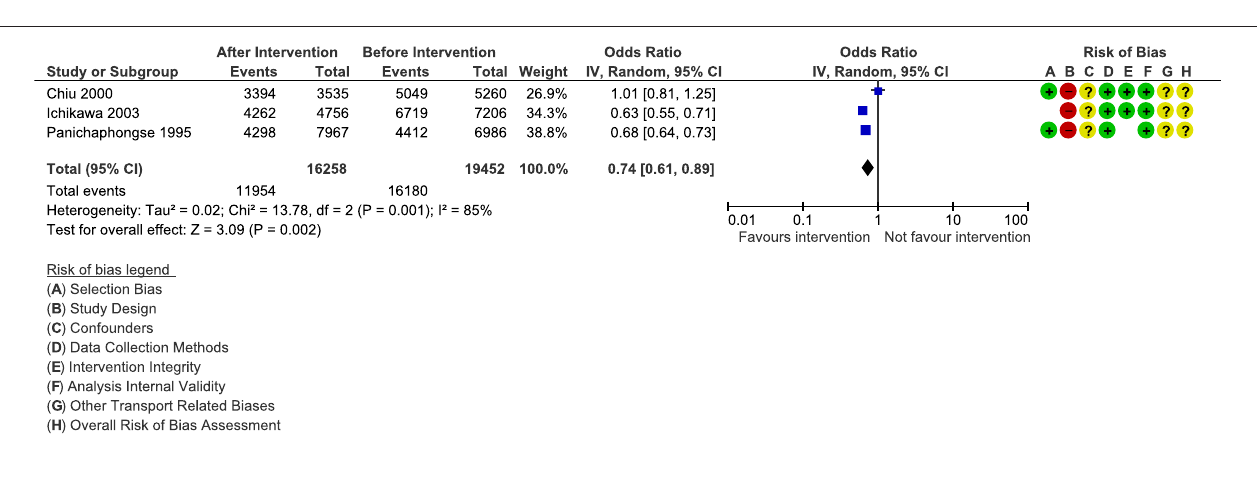
FIGURE 7 | Primary outcome: changes in the number of ‘injuries’ after mandatory helmet law enforcement.